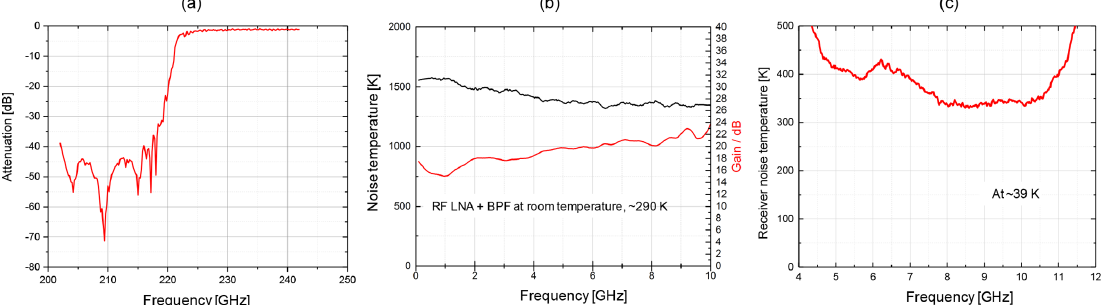
Figure 2. (a) The frequency response of the waveguide filter (BPF in Fig. 1) used in CORAM to suppress the unwanted sideband signal at 213.5GHz. (b) The noise temperature and gain of the RF LNA + BPF (Fig. 1) at room temperature. (c) The noise temperature for CORAM after down-conversion to 8.5GHz. This measurement is made after the first IF LNA (Fig. 1) and before the second down-conversion to 0.5GHz. The cryocooler components are at 39K. The single sideband system temperature for CORAM is ∼ 600K (Sect.